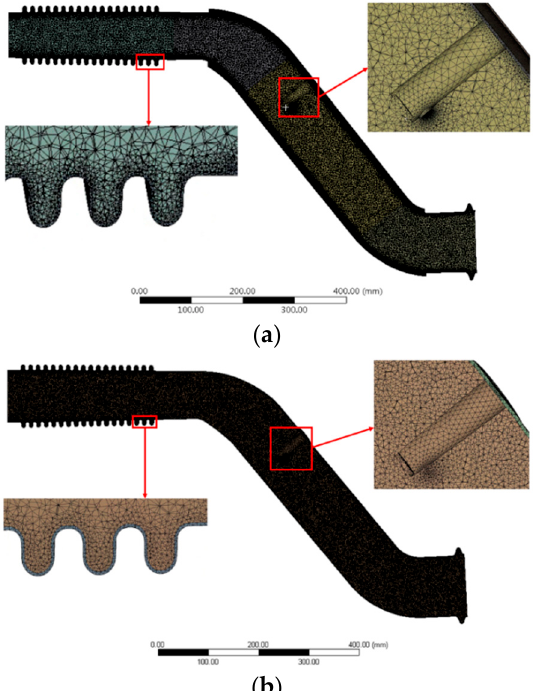
Figure 5. The grids of two kinds of geometric models: ( a ) section of grids for the double-layered pipe; ( b ) section of grids for the single-layered